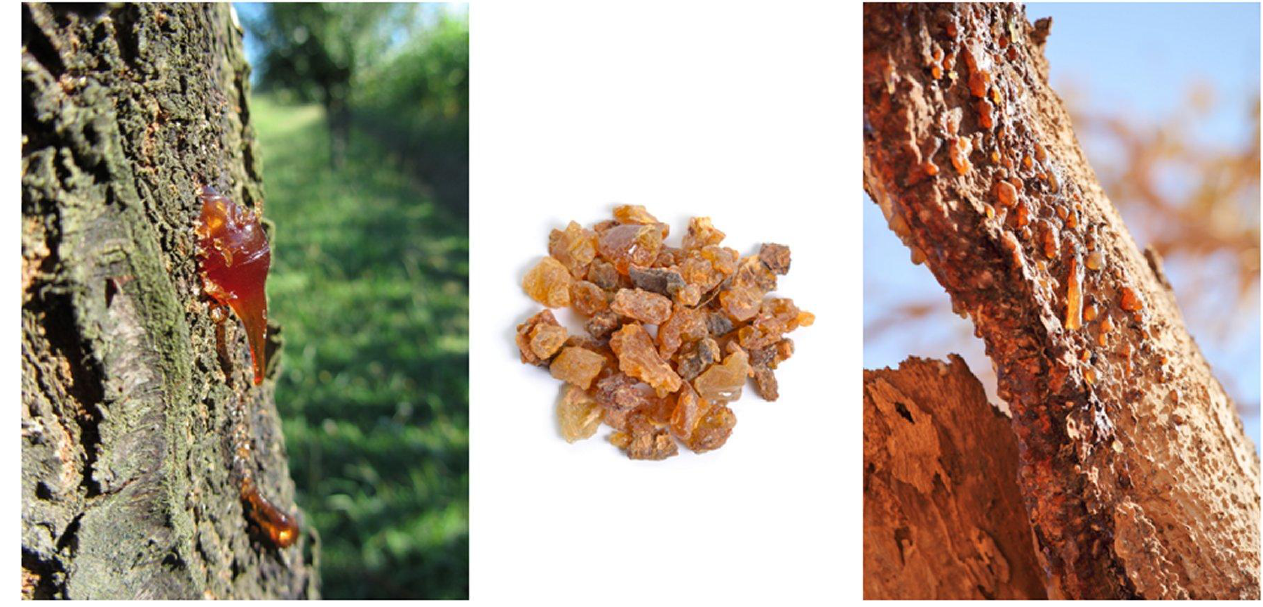
Figure 1: Myrrh resin. Pictures extracted from reference